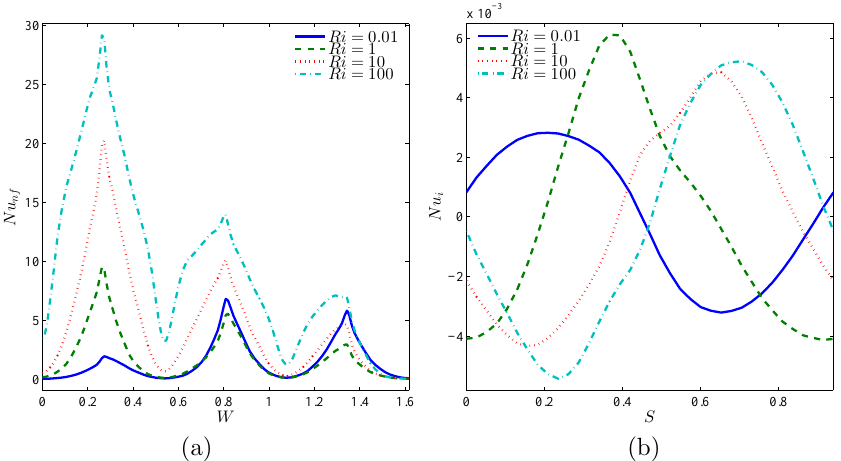
Figure 9. Variations of local Nusselt number interfaces with ( a ) W and ( b ) S for different Ri at Case 2 ( − Ω ), φ = 0.02, N = 3, and R = 0.15.